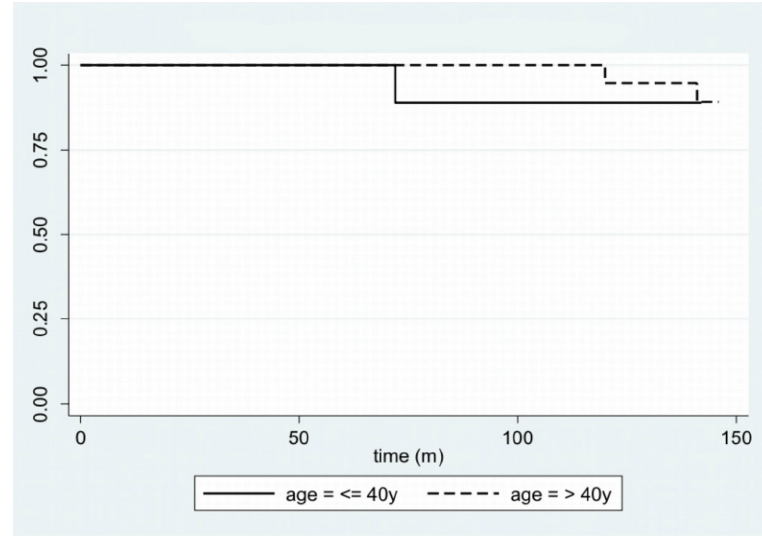
Figure 2. Kaplan–Meier plot for disease-free survival, stratifying the sample by age.